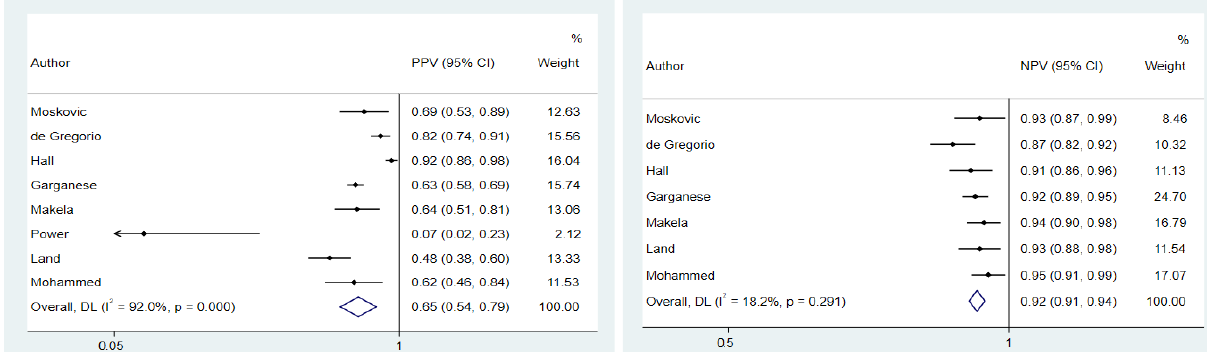
Figure 3. Forest plot for positive predictive value and negative predictive value. There was a pooled LR+ and LR − of 6.44 (95% CI: 3.72–11.4) and 0.20 (95% CI: